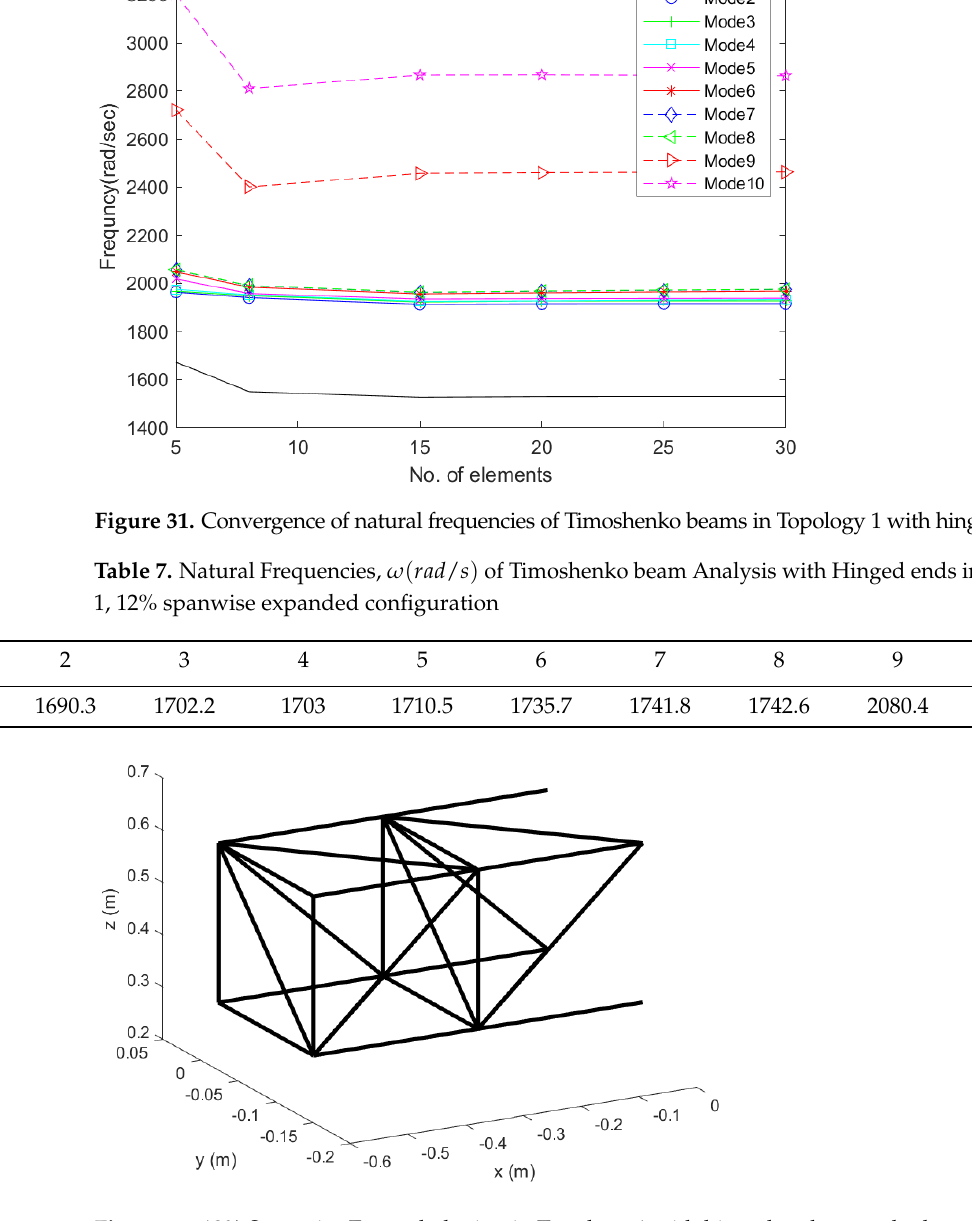
Figure 32. 12% Spanwise Expanded wing in Topology 1 with hinged ends; morphed